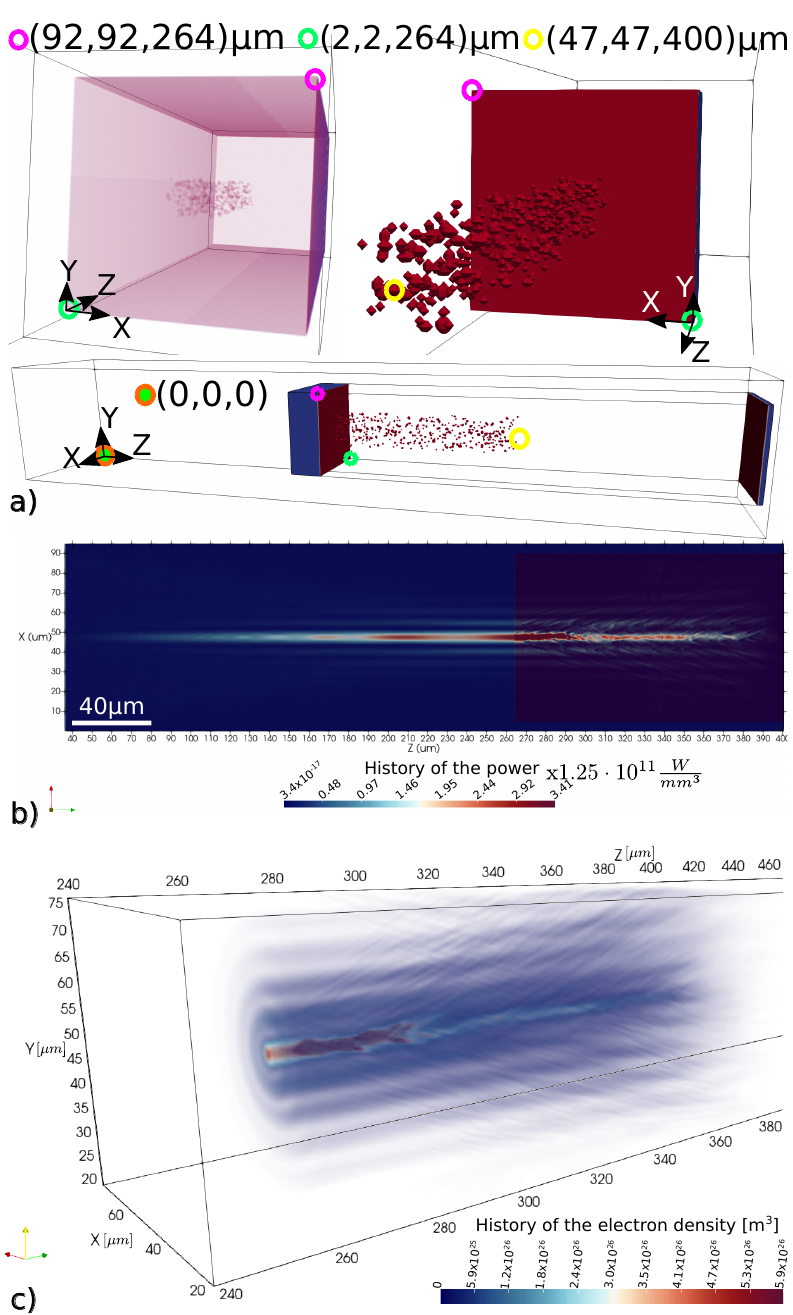
Figure 7. ( a ) Computational domain including clusters of spherical nanovoids, randomly located inside the fused silica bulk. ( b ) Power history of the pulsed Bessel beam propagating inside the nanoporous block. ( c ) History of the photo-ionized electrons density in the complete